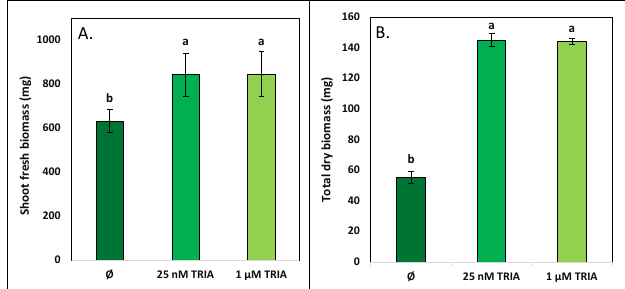
Fig. 3: Effects of two concentrations (25 nM and 1 μM) of triacontanol (TRIA) on fresh shoot weight (A.) and total dry biomass (B.) of young spinach plants (Ø stands for the control group). Vertical bars represent ± standard error from means (n=5), different letters above the columns indicate significant differences at P < 0.05 (Tukey’s HSD test)